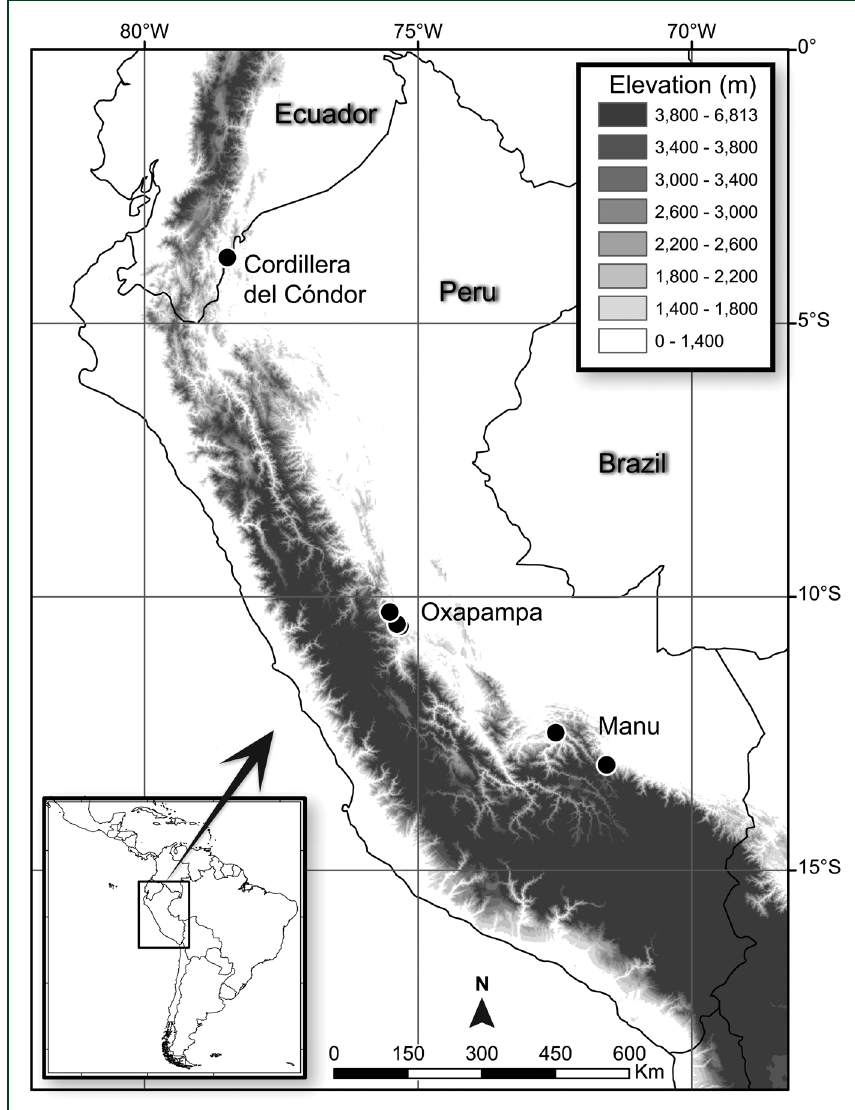
Figure 2. Distribution map of Incadendron esseri